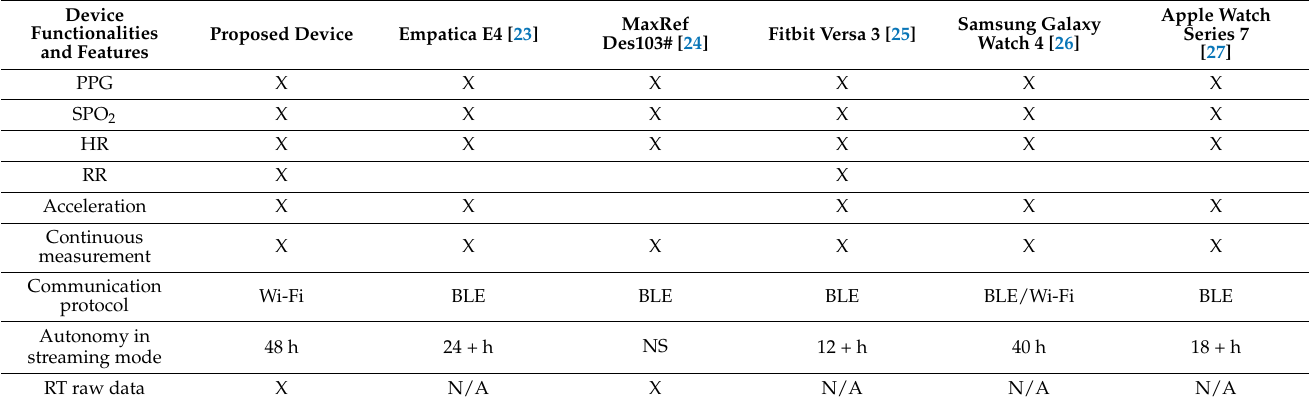
Table 2. Indicative functionalities and features of prototypes emerged from literature